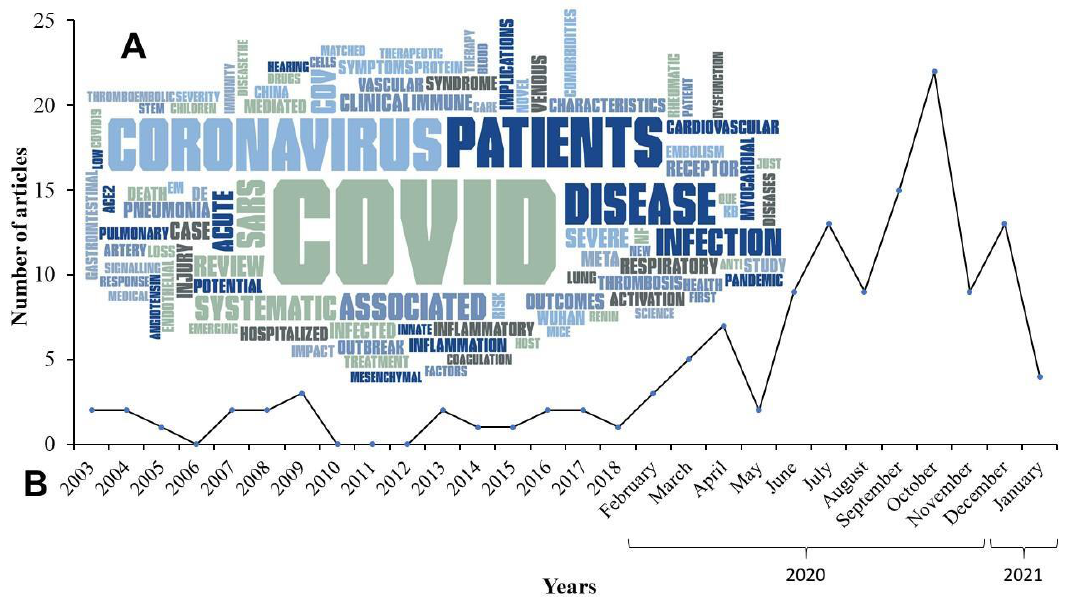
Figure 2. ( A ) Word cloud with the 100 most frequent words found in the titles of all studies that are part of this review, as well as a temporal analysis of the publications available in this review. ( B ) Frequency of publication (by year (2003-2018) and month (2020 to 2021)) of the 134 references used in this study.